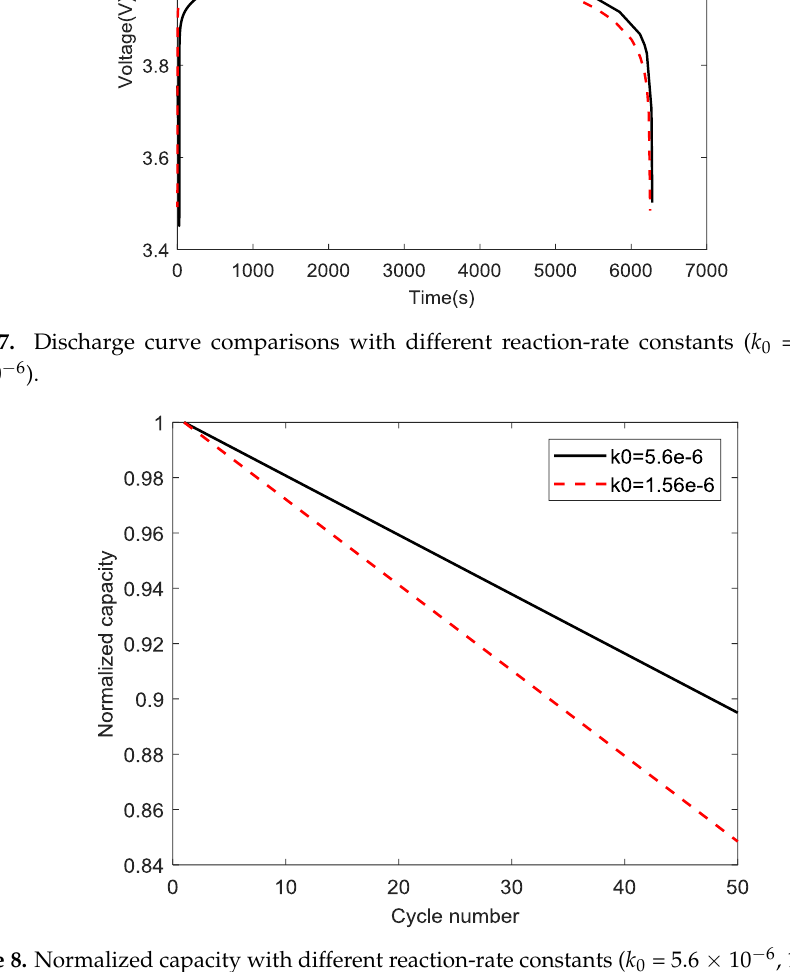
Figure 8. Normalized capacity with different reaction-rate constants ( k 0 = 5.6 × 10 − 6 , 1.5 × 10 − 6 ).